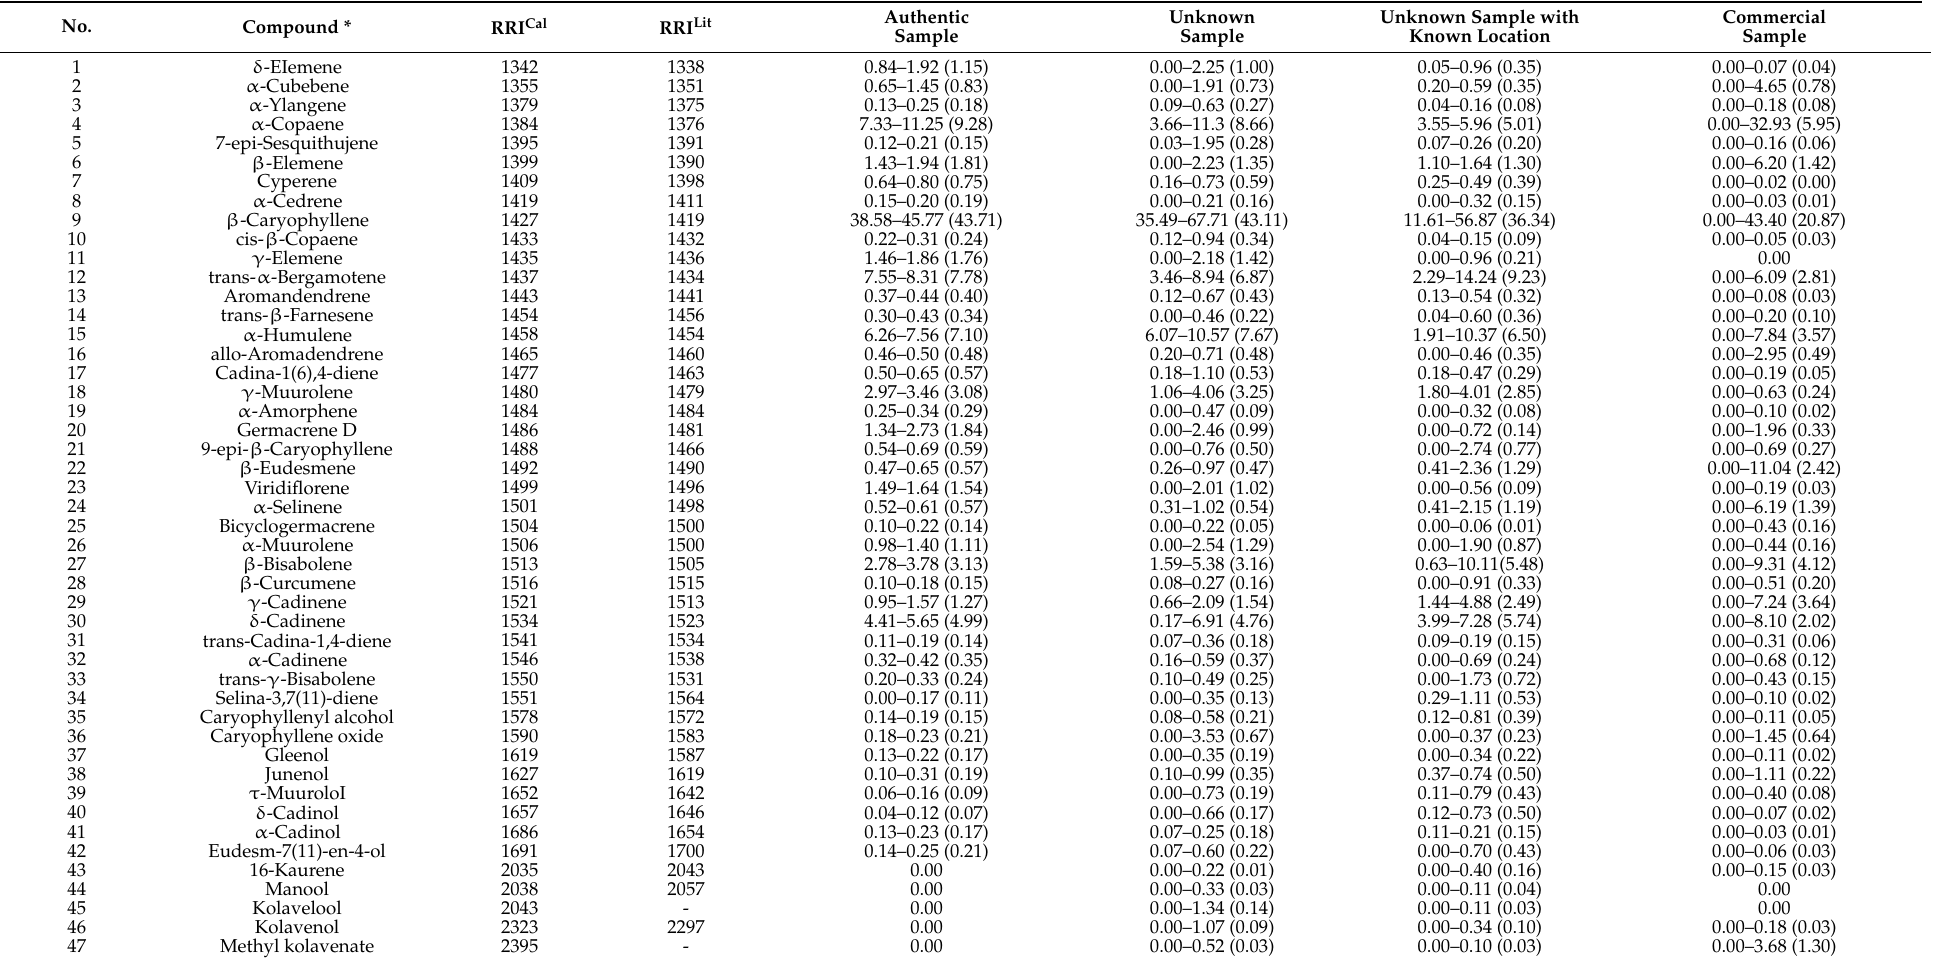
Table 1. Tentative compound identification and range (average) of constituent concentration (peak area %) of copaiba